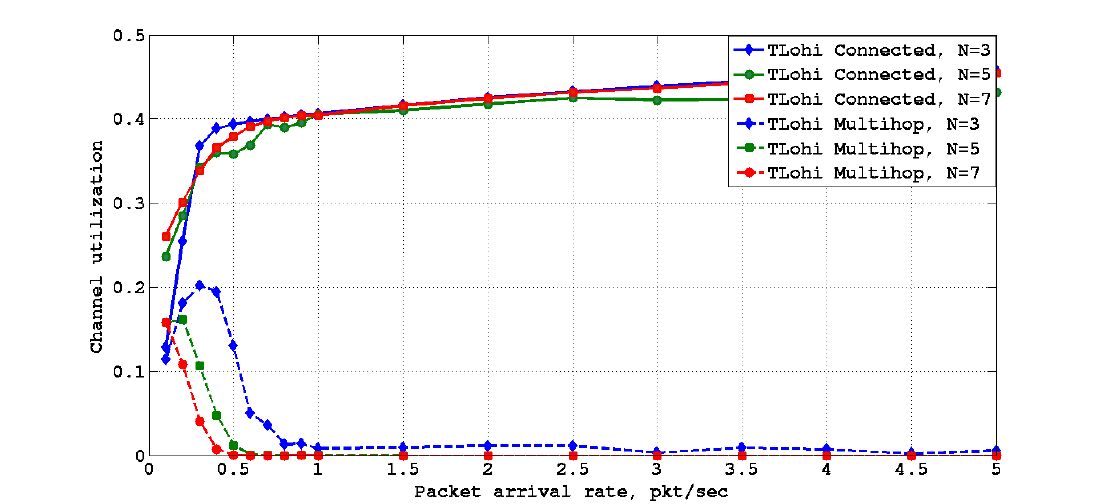
Figure 9. Effect of hidden nodes on T-Lohi MAC protocol.